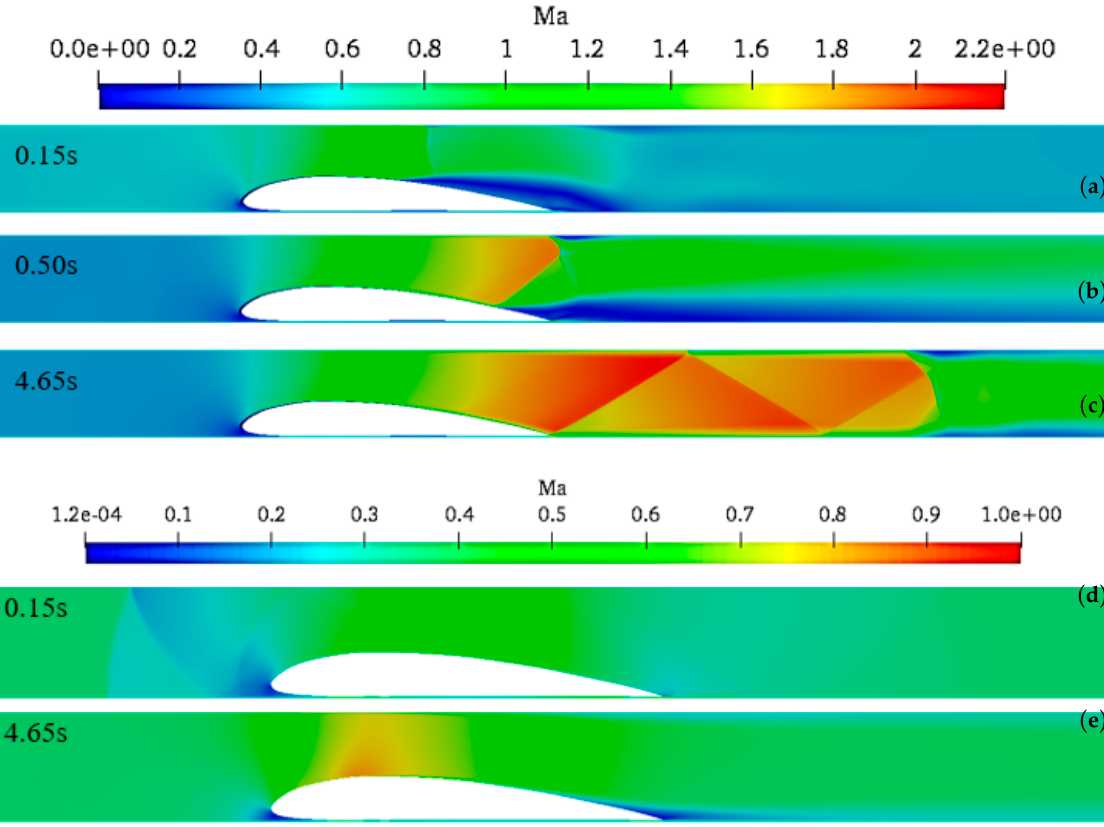
Figure 7. Mach number field visualization: ( a ), ( b ), ( c ) results for 𝑝 (cid:2998) = 100 Pa and 166 m/s velocity of the vehicle; ( d ), ( e ) results for 𝑝 (cid:2998) = 10 kPa and 125 m/s velocity of the vehicle.